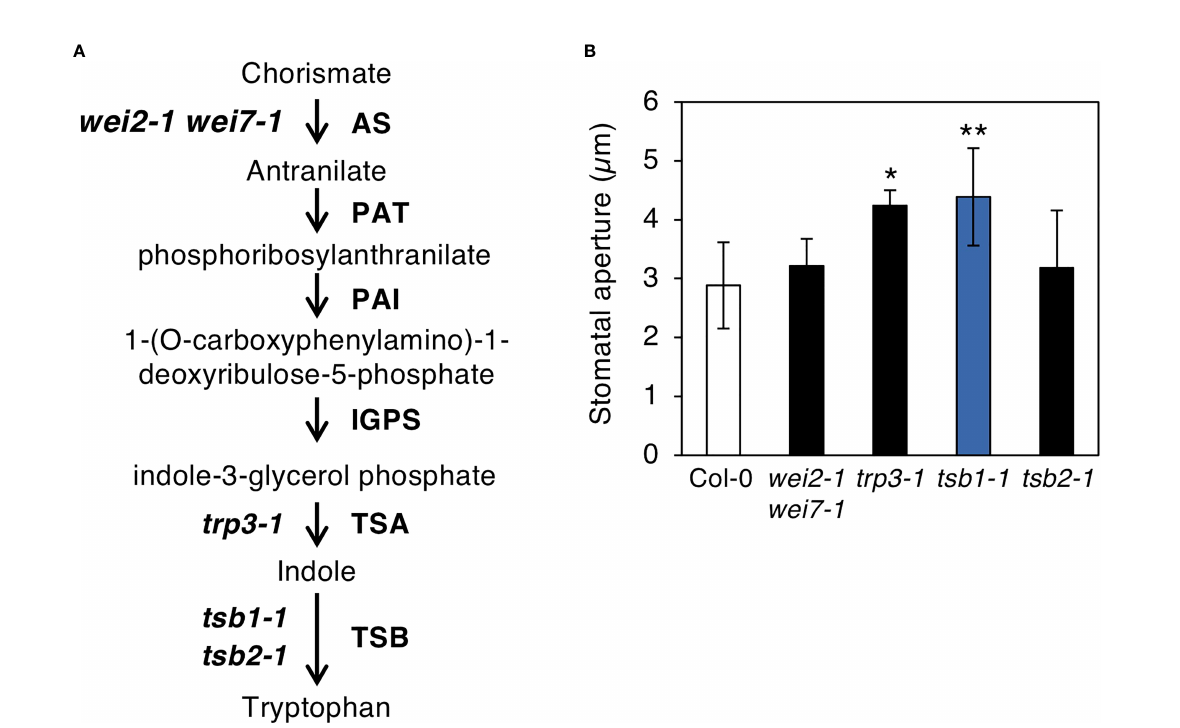
FIGURE 5 Characterization of the mutants related to Tryptophan biosynthetic pathway. (A) Tryptophan biosynthetic pathway in Arabidopsis thaliana . Tryptophan biosynthetic pathway starting from chorismate are shown with the enzymes of each step (right) and the mutants used in this study (left). AS, anthranilate synthase; PAT, anthranilate phosphoribosylanthranilate transferase; PAI, phosphorybosylanthranilate isomerase; IGPS, indole-3-glycerol phosphate synthase; TSA, tryptophan synthase a subunit; TSB, tryptophan synthase ß subunit. (B) Stomatal aperture of Tryptophan biosynthetic mutants under illuminated growth condition. Epidermal tissues were isolated from 5-week-old plants grown on MS plate for 4 weeks and transferred to soil for 1 week at ZT4-7 and immediately subjected to measurement of stomatal aperture. Values represent mean ± SD (n = 3); measurement of > 25 stomata in each experiment Asterisks indicate a signi fi cant statistical difference relative to Col-0 by Student t test (* P < 0.05, ** P <